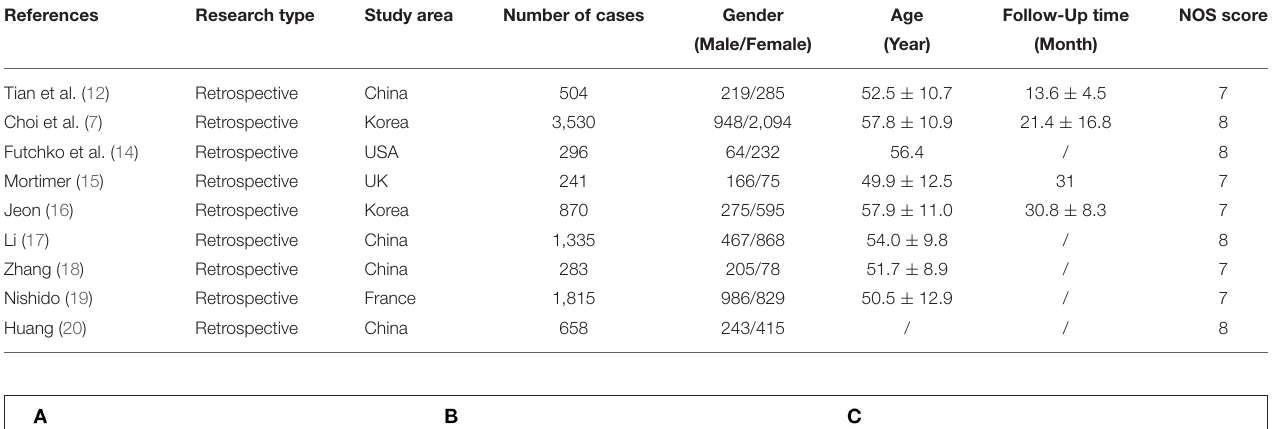
TABLE 1 | Baseline characteristics and quality assessment of the included studies.